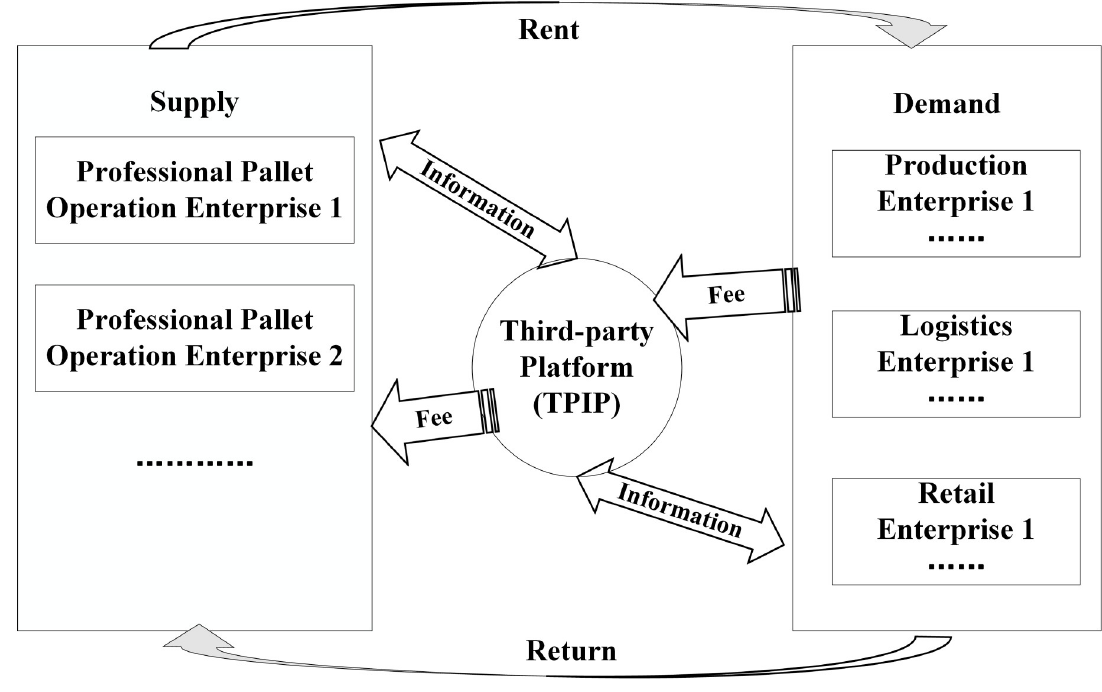
Fig 1. Flow chart of the